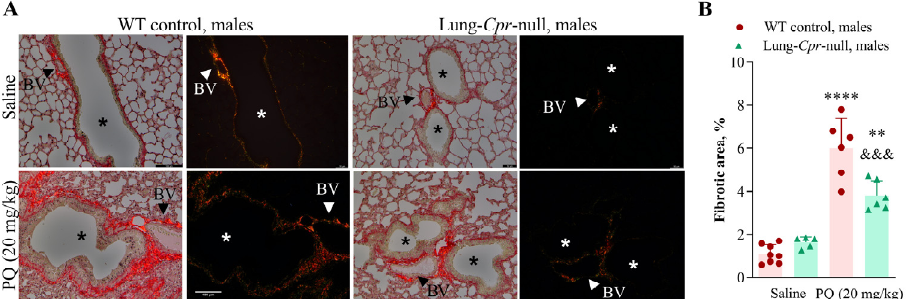
Figure 3. PQ-induced collagen deposition in the lungs of male mice. Three- to four-month old male lung- Cpr -null mice and WT control littermates received a single intraperitoneal injection of saline or PQ (20 mg/kg). The lungs were harvested on day 15 after the injection, embedded in paraffin and stained with picrosirius red. The deposition of collagen fibers was evaluated in seven to 12 microscopic fields per lung section, at × 200 magnification, using brightfield ( left ) and polarized light ( right ) microscopy. ( A ) Representative images of lung sections with deposited collagen are shown (BV, blood vessel; *, airway; scale bar is 100 µ m). ( B ) The fibrotic lesion area (%) with excessive deposition of collagen was quantified as described in Material and Methods . Results represent means ± S.D. ( n = 5–8 per group). &&& , p < 0.001, by mouse genotype; **, p < 0.01, ****, p < 0.0001, by exposure (one-way ANOVA followed by Bonferroni’s test for multiple comparisons).